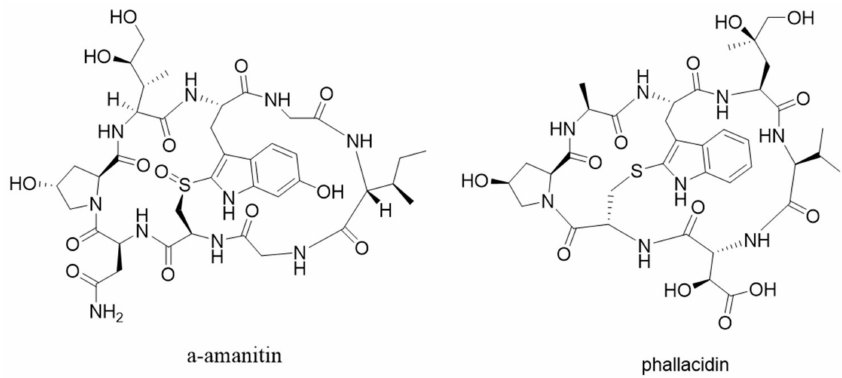
Figure 2. Structures of α -amanitin and phallacidin.